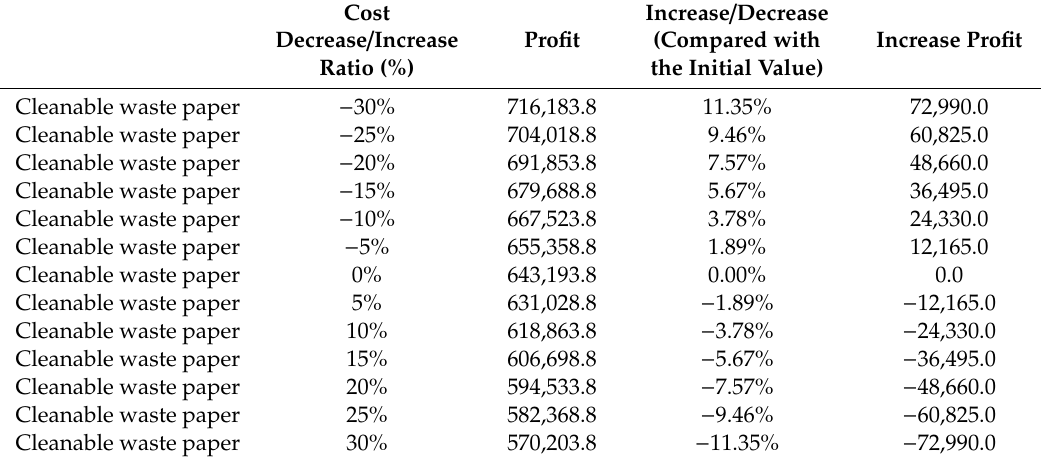
Table 4. Sensitivity analysis on the cost of clean waste paper.